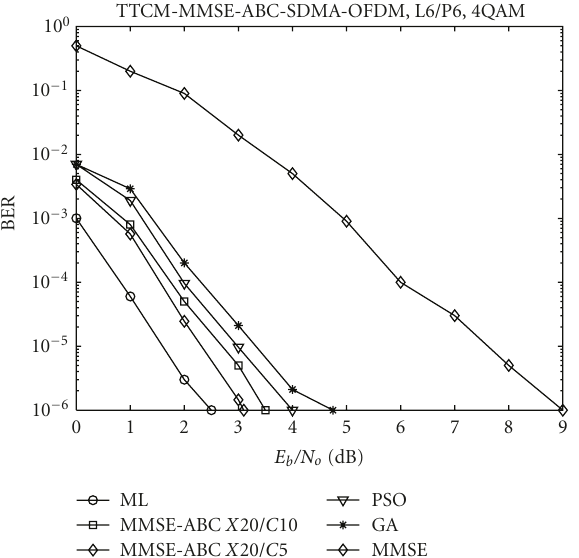
Figure 5: BER versus E b /N o performance comparison of 8 × 6 system for 16-QAM demodulator.